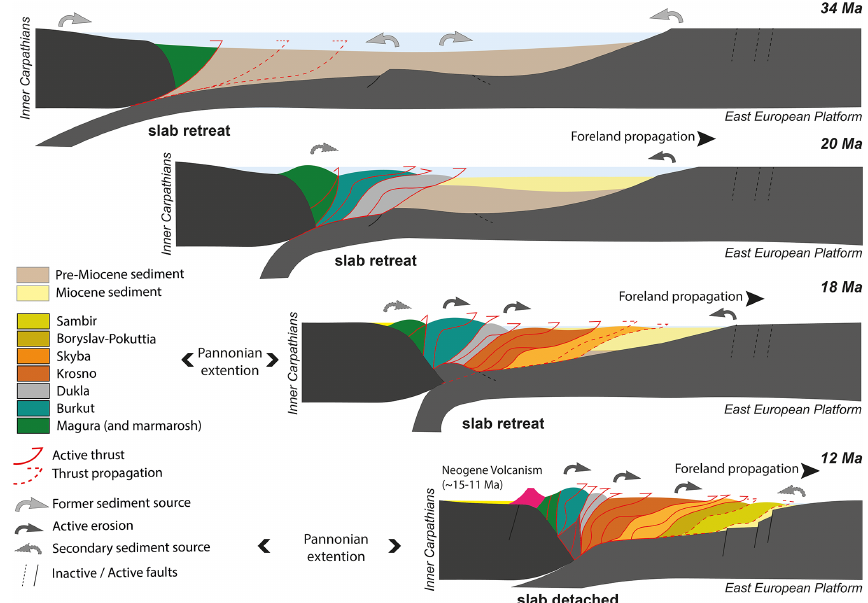
Figure 13. Sketch of the construction of the Ukrainian Carpathian wedge from 34 to 12Ma. Dashed red lines are thrusts that will propagate during the next time step. Full red lines with arrows on top are thrusts that are active or will reactivate, and full red lines without arrows are sealed. Light grey arrows show the source of sediment supply to the different basins. Dark grey arrows are for the active erosion of the nappe. For the 12Ma sketch, foreland propagation terminated around 11.5Ma (Nemˇcok et al., 2006). Not to